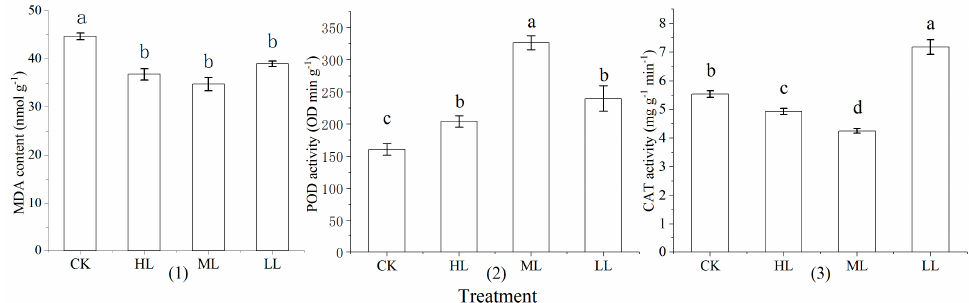
Figure 4. The MDA content ( 1 ), POD enzyme activity ( 2 ), and CAT enzyme activity ( 3 ) of J. regia f. luodianense seedlings treated with various light intensities. Different lowercase letters represent significant differences between treatment groups ( p < 0.05). CK: 100% full light treatment; HL: 75% full light treatment; ML: 50% full light treatment; LL: 25% full light treatment.